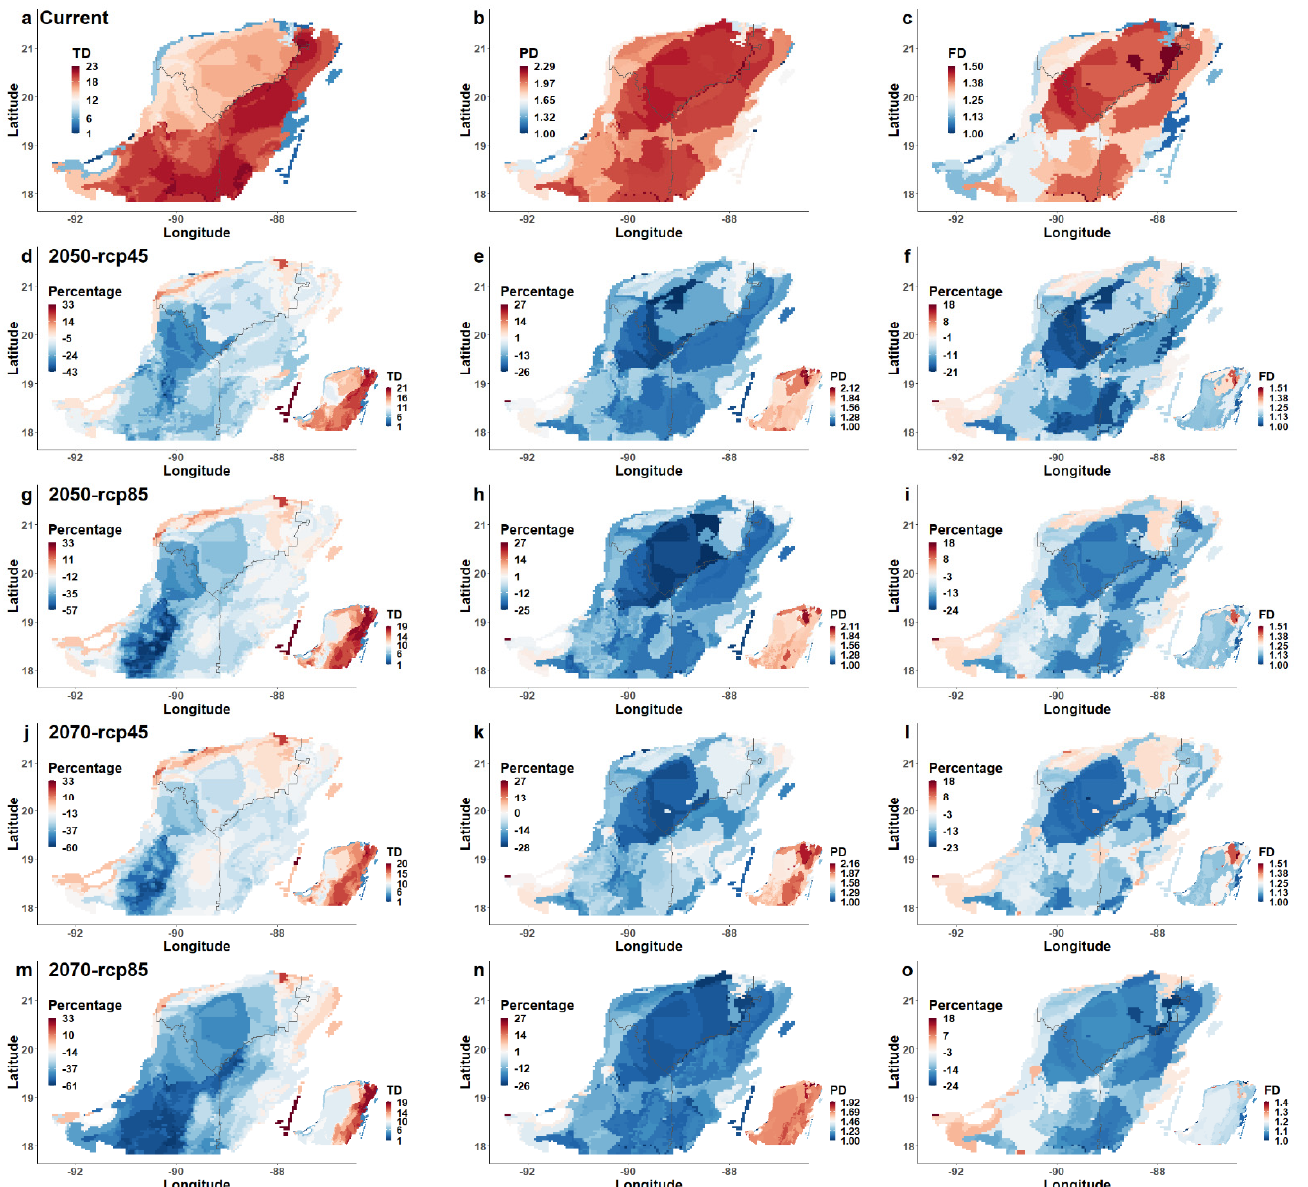
Figure 2. Percentage changes in diversity patterns throughout the evaluated scenarios. Positive percentage values mean projected increase in a diversity measurement in the future scenarios compared with the current. Negative percentage means the opposite, that is a decrease in diversity regarding to the current scenario. Columns indicate diversity dimensions and rows current and future scenarios. Current scenario: ( a – c ); 2050-rcp45: ( d – f ); 2050-rcp85: ( g – i ); 2070-rcp45: ( j – l ), and 2070-rcp85: ( m – o ). Inset plots represent raw values for each diversity dimension.